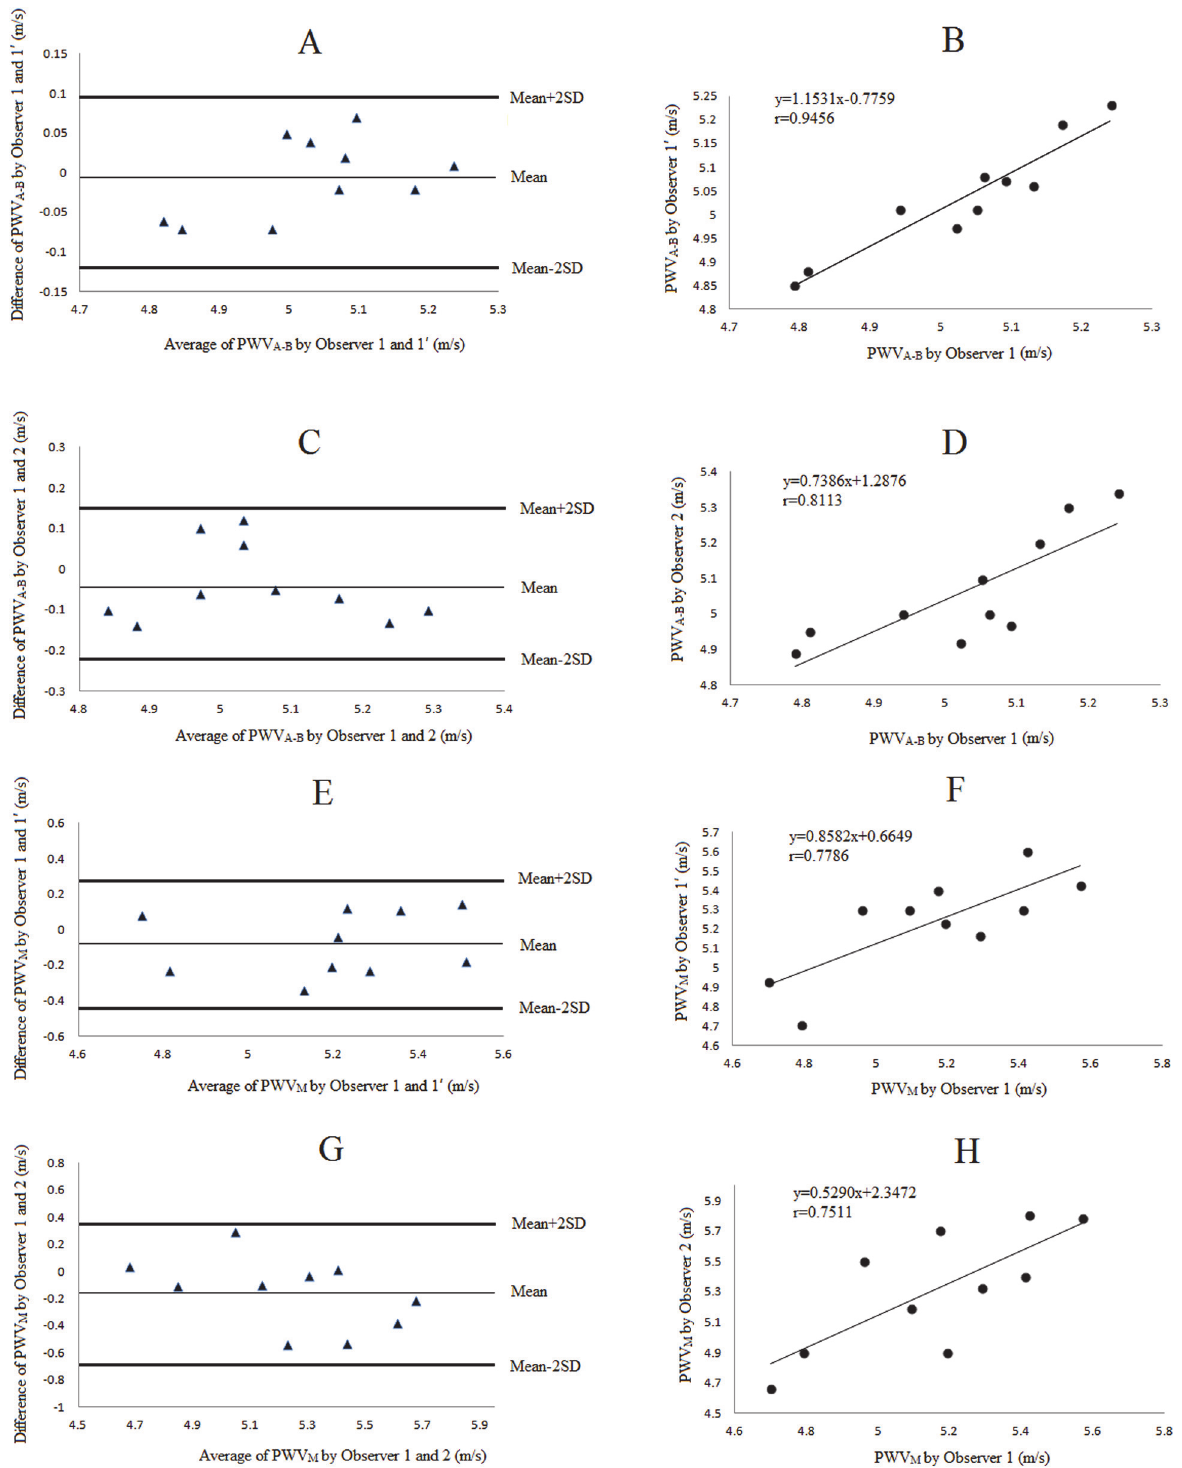
Fig 3. The reproducibilities of the PWV measurements in the in vitro experiment. Intra- (A, B) and inter-observer (C, D) variability of PWV A-B , intra- (E, F) and inter-observer (G, H) variability of PWV M were demonstrated by Bland-Altman plots and linear regression analysis, respectively. Abbreviations as in Fig. 2.